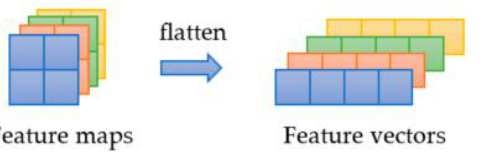
Figure 10. Reshape operation for an input feature map of the transformer module.